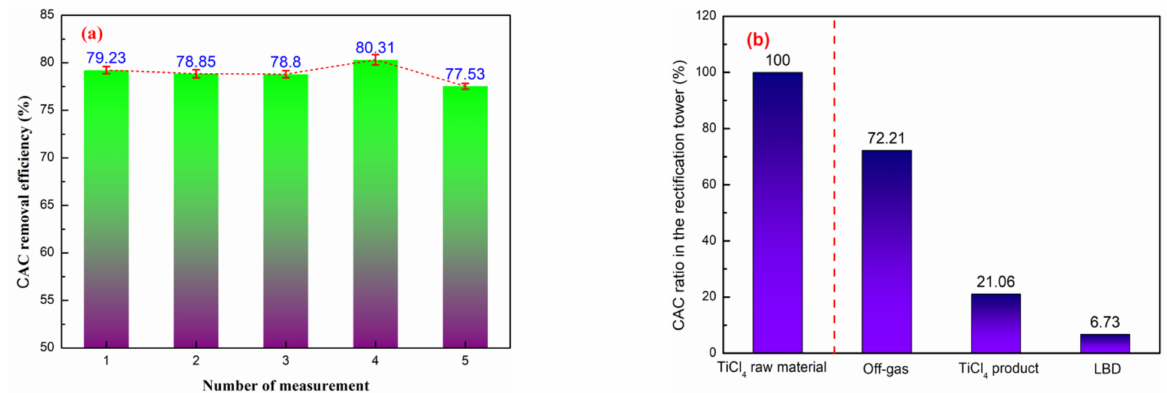
Figure 8. ( a ) The stability of CAC removal efficiency and ( b ) distribution of CAC impurities during the rectification